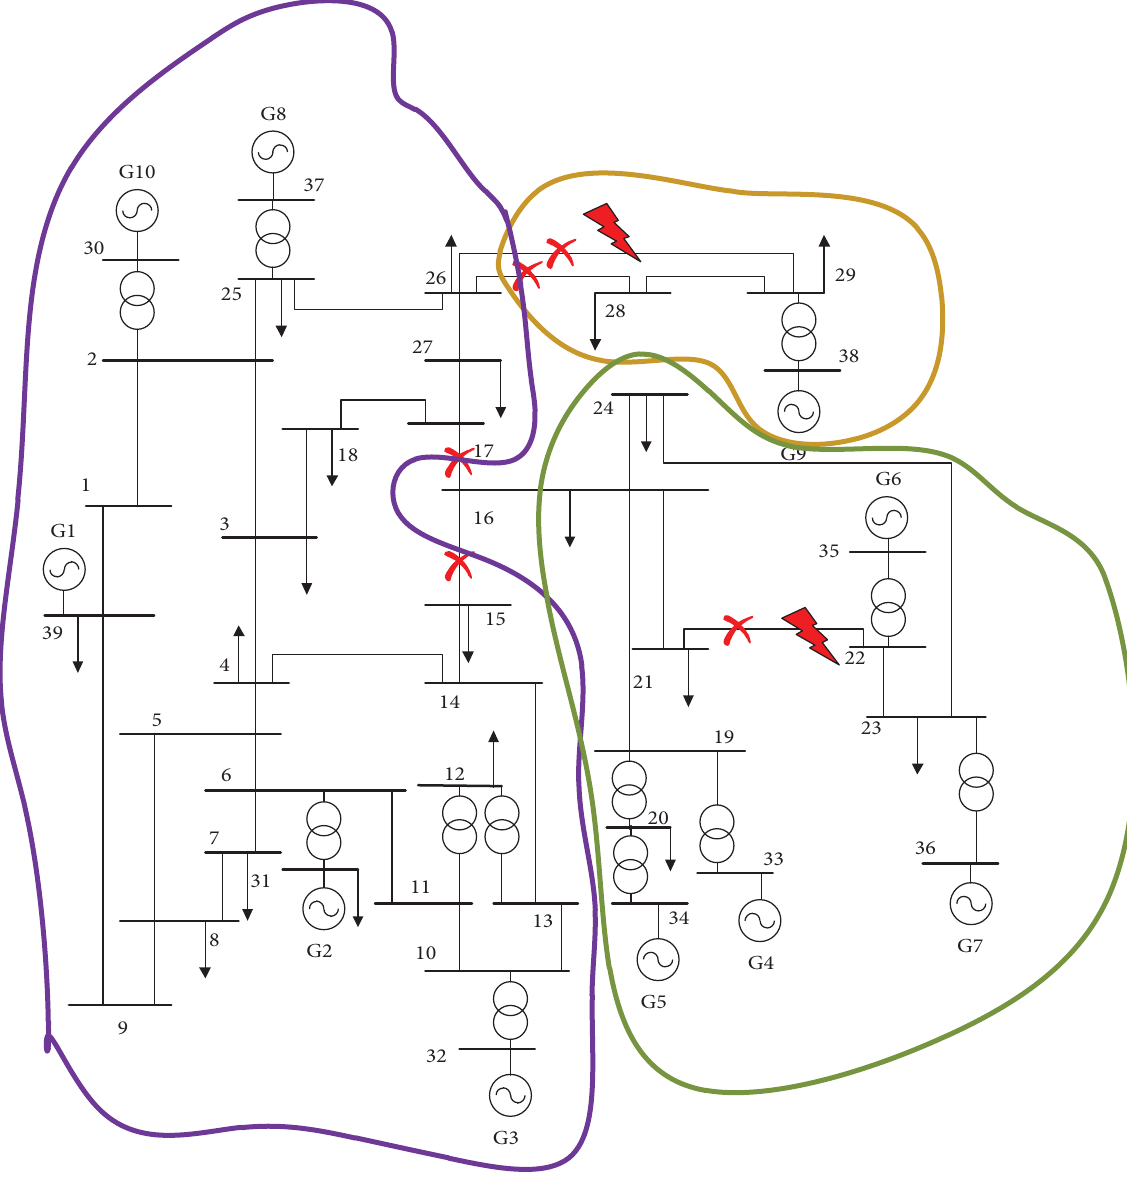
Figure 23: Separating the 39-bus system into three